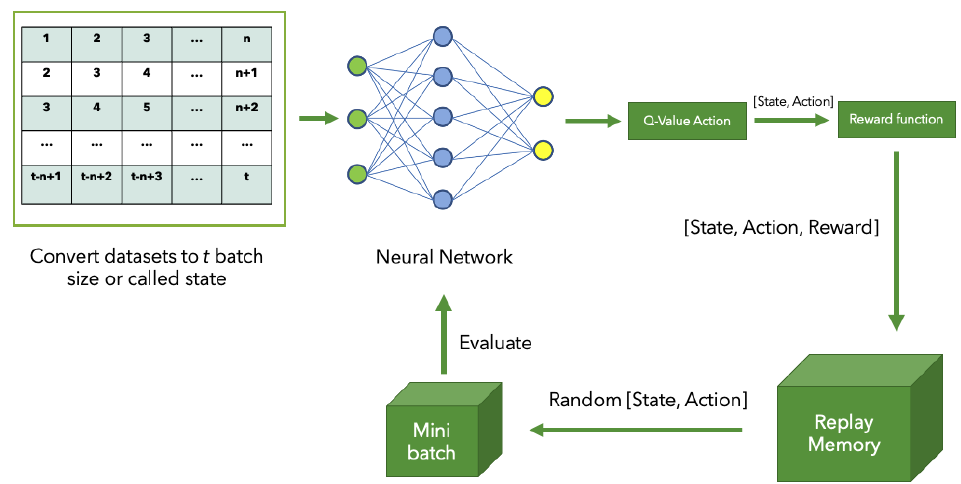
Figure 1. Overall process of DRL (Deep Reinforcement